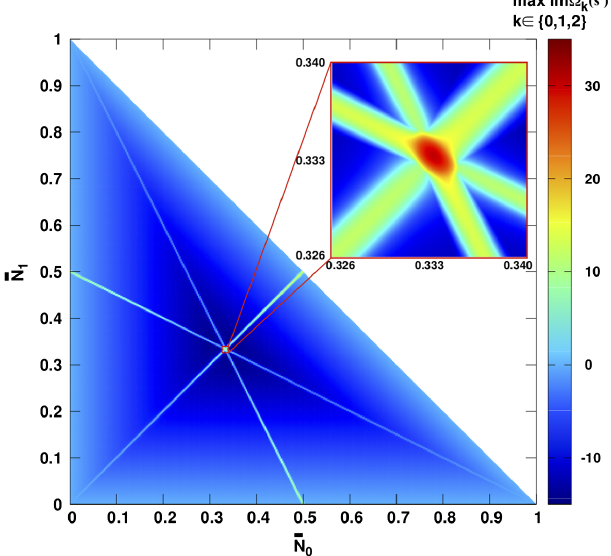
FIG. 3. Largest imaginary part (largest growth rate) of the complex frequency shifts given by Eq. (22) for the equidistant multibunch configuration with M ¼ 3 . I 0 ¼ 12 . 7 mA.